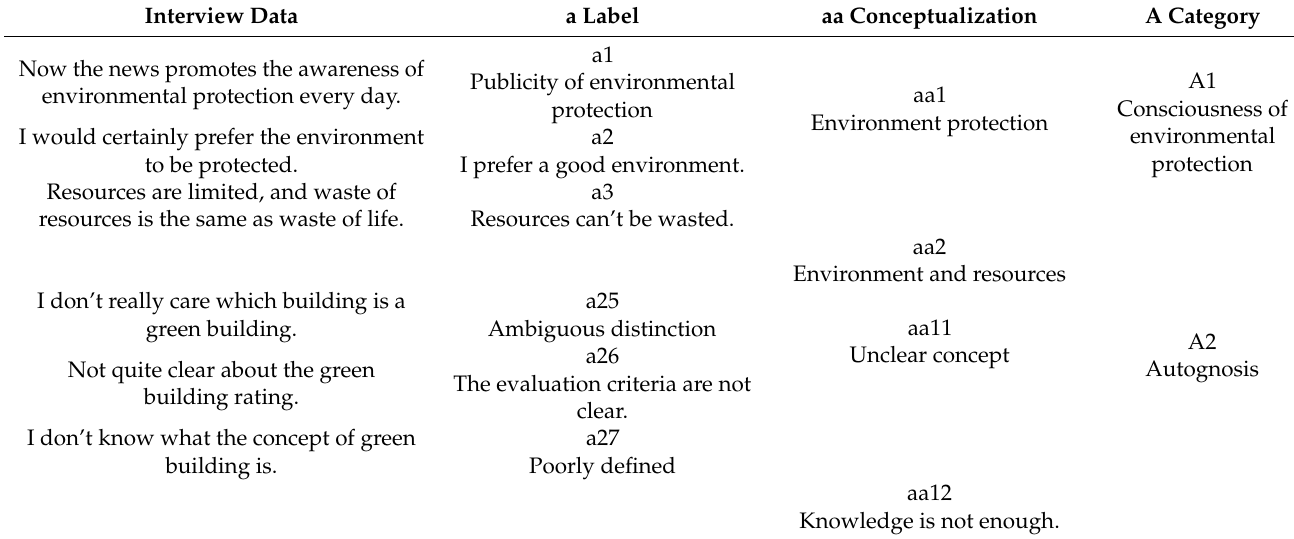
Table 3. Open coding of interview data on the influencing factors of the general public’s cognition of green building. Interview